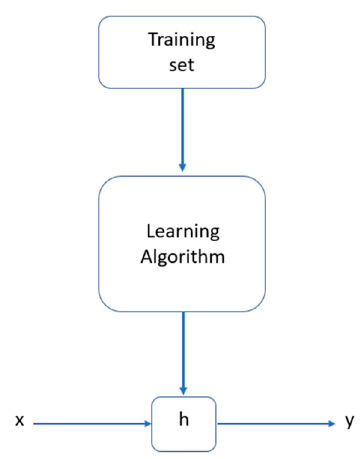
Figure 14. Schmatic representaiton of the machine learning model.